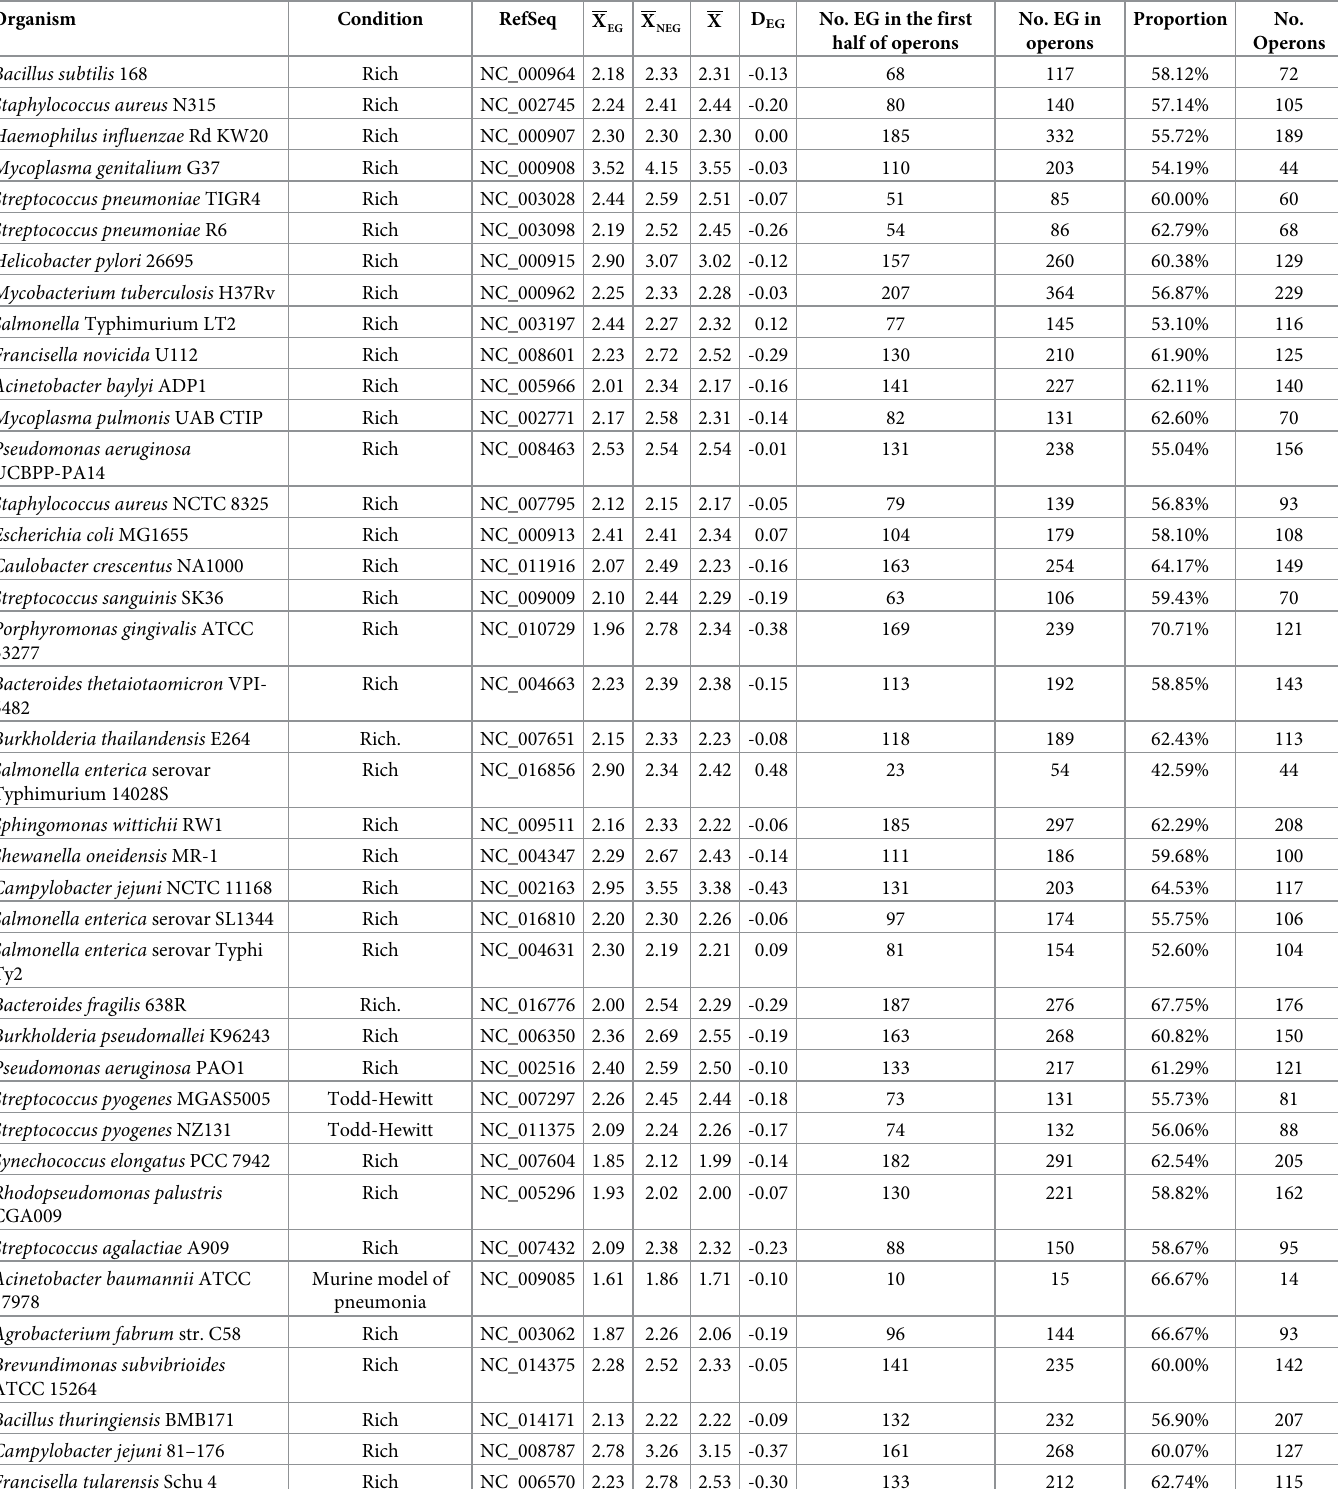
Table 1. The average position distribution of essential and non-essential genes in operons and the proportion of essential genes in the first half of operons.